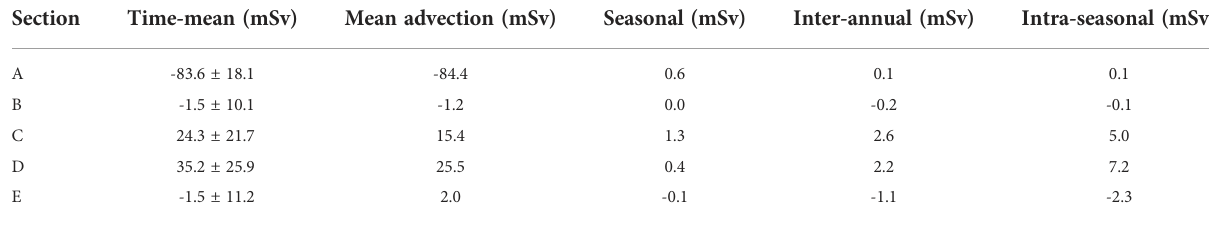
TABLE 1 A summary of time-mean FWT (± standard deviation) through the 5 sections as shown in Figure 4B and the four components that contribute to the time-mean FWT as shown in Figure 6